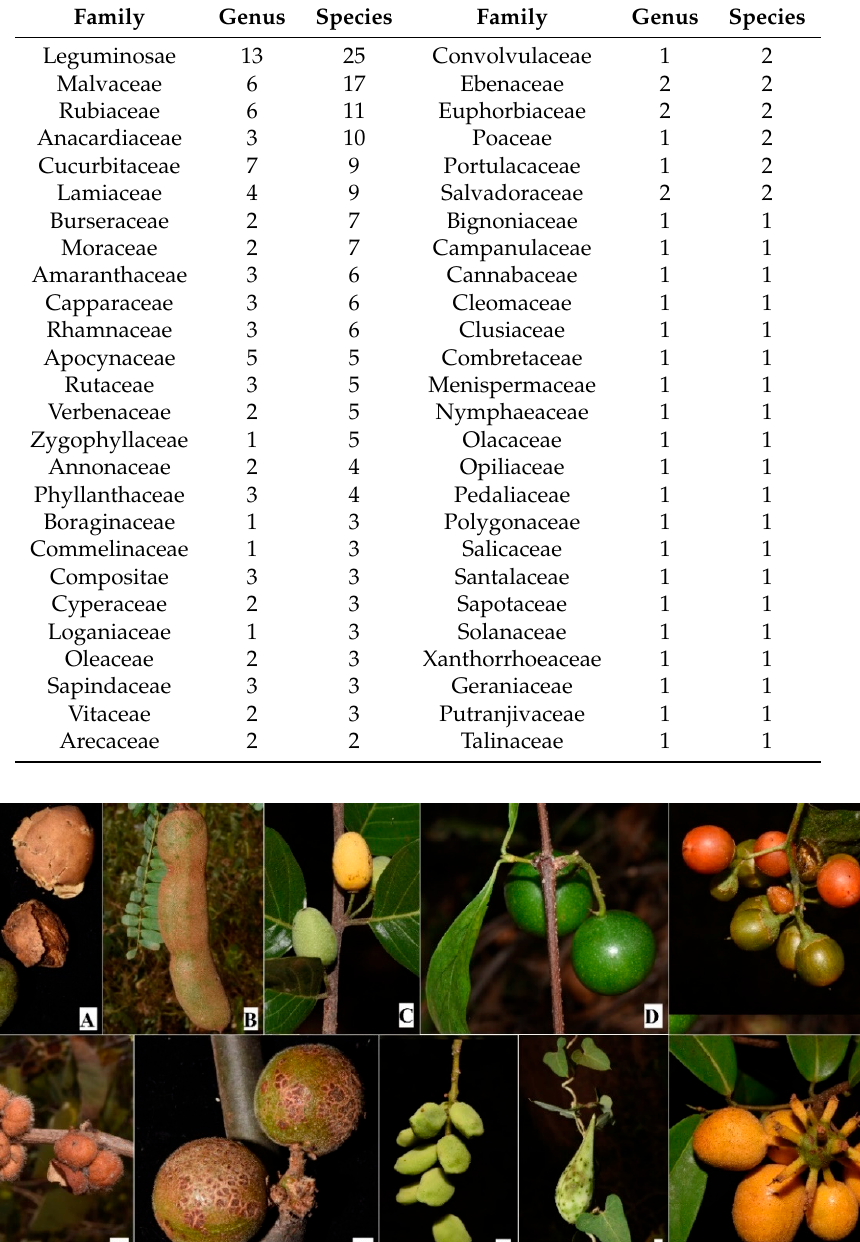
Table 1. Number of genera and species of wild edible plants in Kitui county by family.